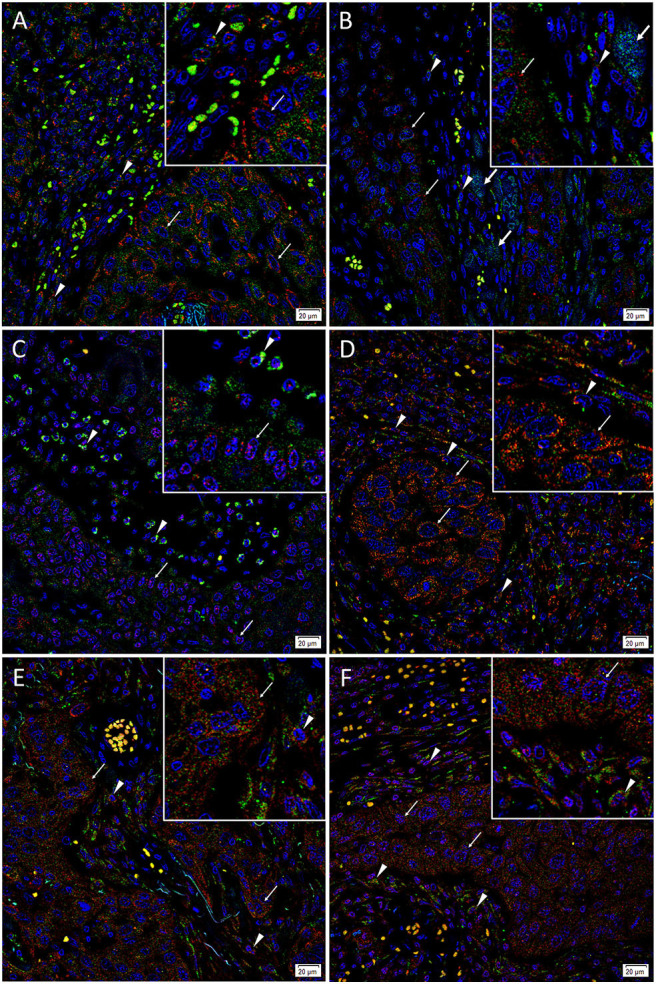
Representative immunofluorescence-stained sections of a metastatic cutaneous head and neck squamous cell carcinoma tissue sample demonstrating expression of induced pluripotent stem cell markers, with abundant expression of c-MYC (A–C, green) on the cells within the peritumoral stroma (PTS, arrowheads) and the tumor nests (TNs, thin arrows). These c-MYC+ cells also demonstrated cytoplasmic expression of KLF4 (A, red). Most of the c-MYC+ cells within the TNs (thin arrows) and few of those within the PTS (arrowheads) also expressed NANOG (B, red) with few c-MYC+ cells within the TNs not expressing NANOG (B, red, thick arrows). These c-MYC+ cells within the TNs (thin arrows) and the PTS (arrowheads) exhibited nuclear and cytoplasmic expression of SOX2 (C, red). The KLF4+ (D, red) cells within the TNs (thin arrows) and the PTS (arrowheads) also expressed OCT4 (D, green). The majority of OCT4+ (E,F, green) cells within the TNs (thin arrows) and the PTS (arrowheads) also expressed NANOG (E, red), and all expressed SOX2 (F, red). All slides were counter-stained with 4′,6′-diamidino-2-phenylindole (A–F, blue). Original magnification 400x. The insets show enlarged views of the corresponding images.